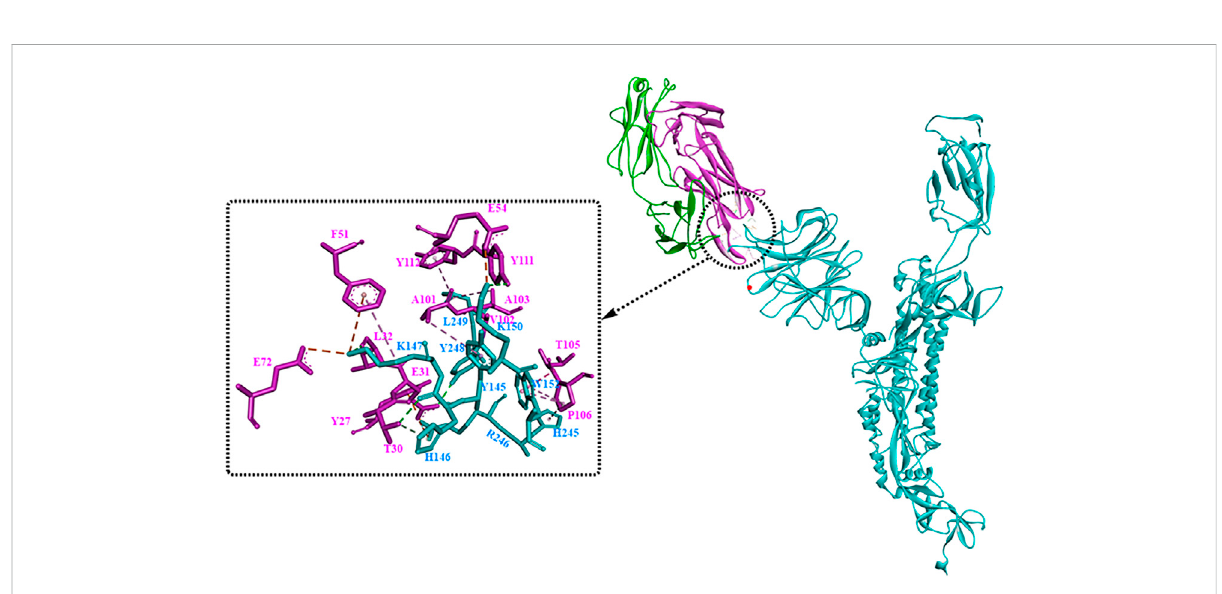
FIGURE 7 The interaction modes of the 4A8 and S-NTD complex